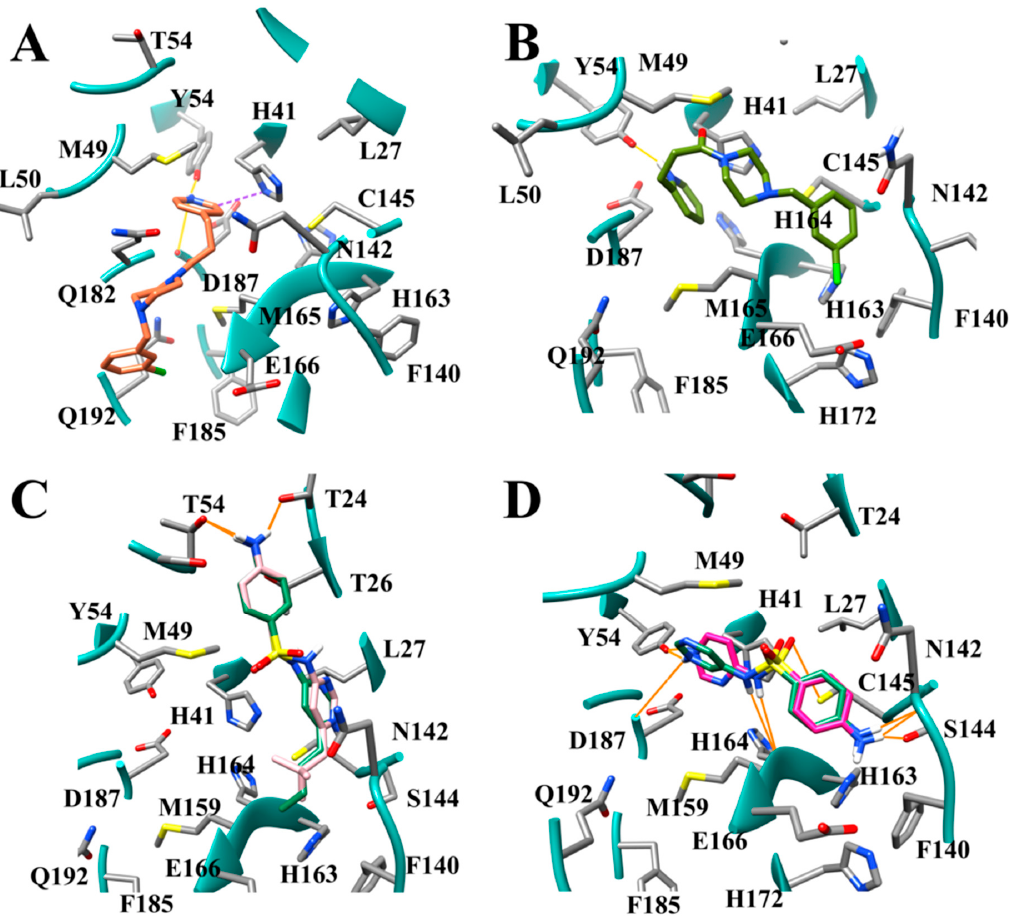
Figure 10. Modes of binding of nitrogen-containing heterocycles. ( A ) DB04 (coral); ( B ) DB02 (olive); ( C ) SD29 (green) and SD25 (pink); ( D ) SD19 (hot pink) and SD20 (sea green). Hydrogen bonds are indicated by solid yellow or orange lines, π - π stacking interactions are shown in purple dash